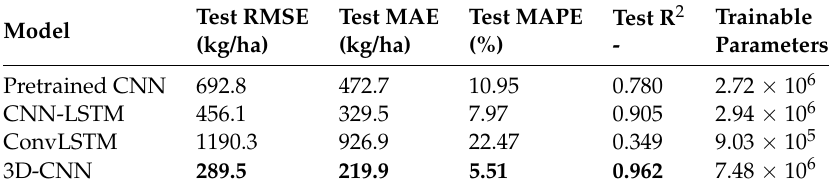
Table 4. The performance metrics of the best-performing models resulting from model-specific hyperparameter tuning process with samples from the test set. The trained models were evaluated with a hold-out test set. Best performance was achieved with the 3D-CNN architecture. The number of trainable parameters indicate the model complexity. Best performance values are in bold text.